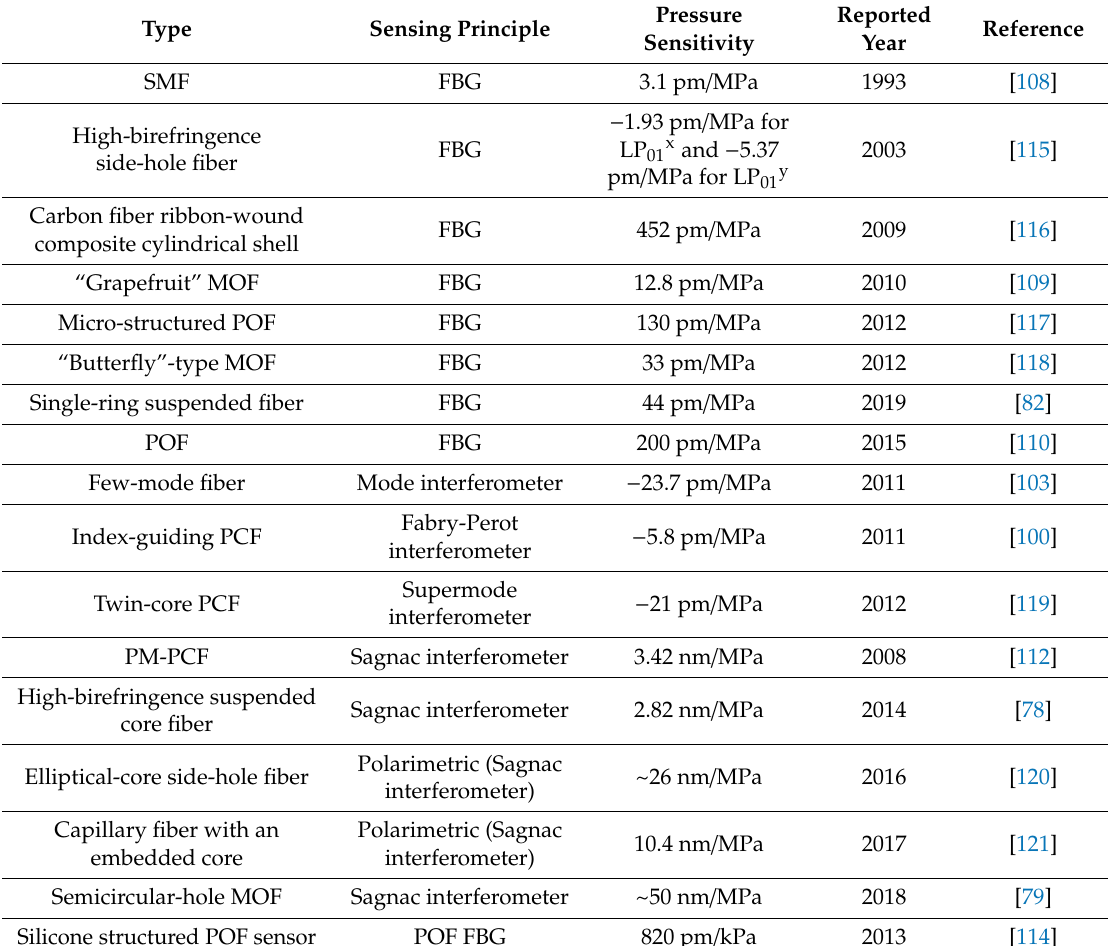
Table 3. Comparison of specialty optical fibers developed for pressure measurement and their